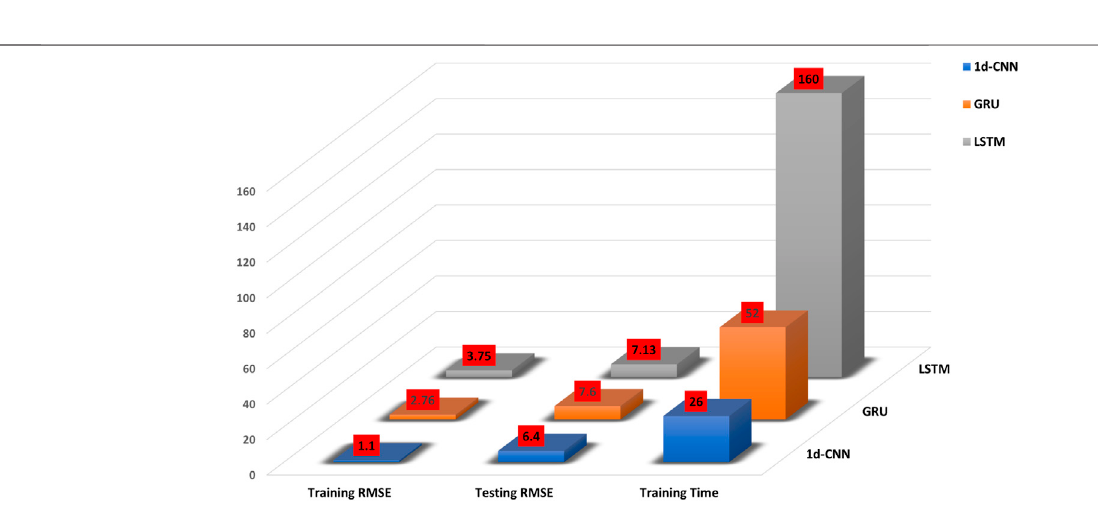
Frontiers in Energy Research |